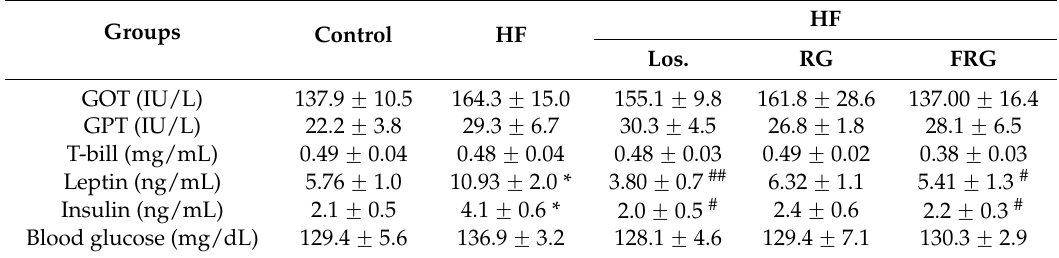
Table 3. Effect of FRG treatment on plasma parameters.